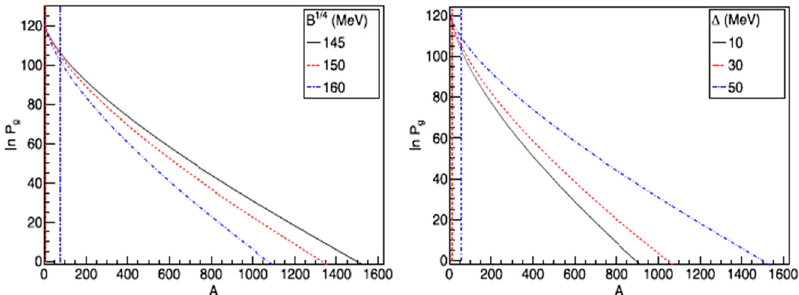
Figure 1. The outcome of multifragmentation calculations of SQM. ( Left )The shape of the probability of a fragment as a function of the baryon number A for a fixed temperature T = 30 MeV for several values of the vacuum energy (inset). ( Right )The same for B 1/4 = 145 MeV and three representative values of the pairing energy ∆ (inset). The vertical blue lines mark the value A crit calculated self-consistently for the given set of parameters. The stability criterion indicates that all fragments (strangelets) to the left of this curve must decay into ordinary hadrons. We see that the overwhelming majority of the matter will not stay in the strangelet form.